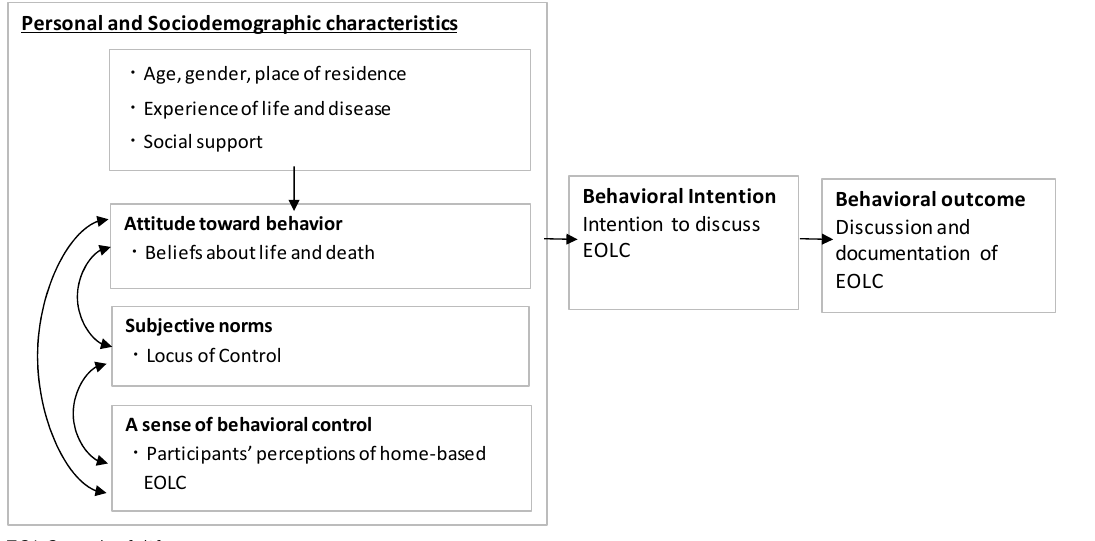
Figure 1. Conceptual framework of this study.